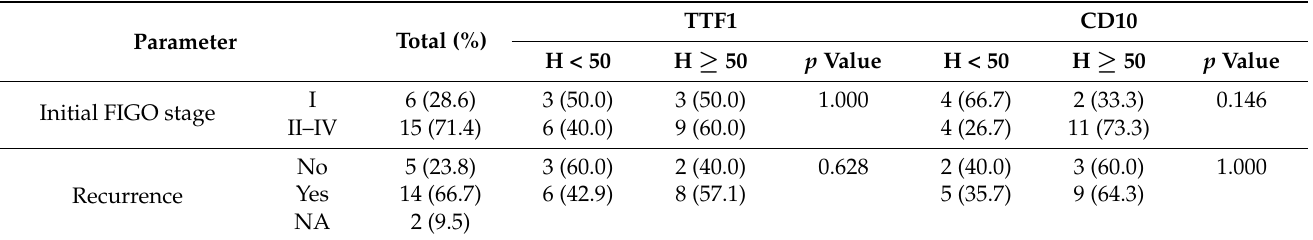
Table 6. Associations of histo score for TTF1 or CD10 with clinicopathological parameters, and DFS.